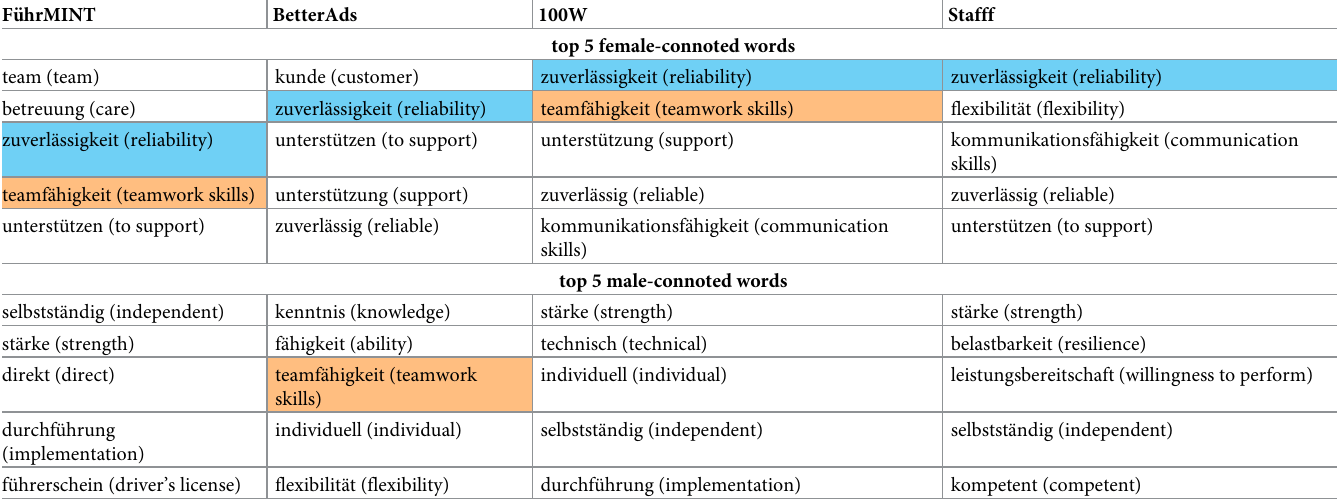
Table 6. Five most frequently extracted female-connoted and male-connoted words per technology. The word ‘zuverla¨ssigkeit’ (‘reliability’), highlighted in cyan, is the only word occurring in the same category for all four providers, while the word ‘teamfa¨higkeit’ (‘teamwork’), highlighted in orange, occurs in both categories. Fu¨hrMINT